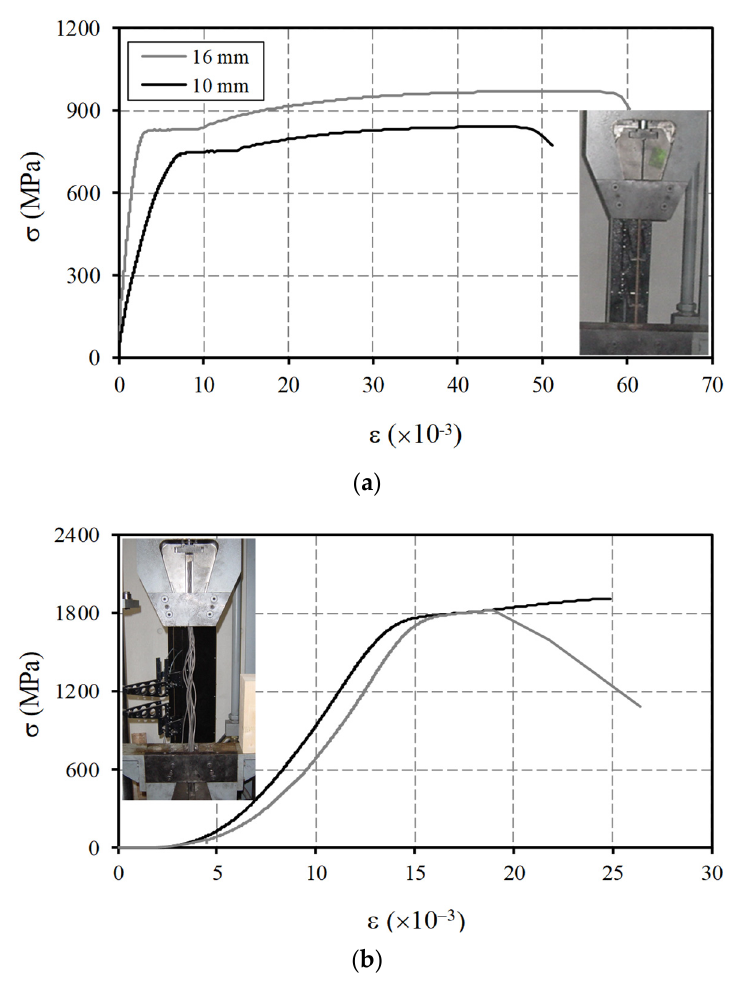
σ ε – curves for reinforcement: ( a ) ordinary and ( b ) prestress. Figure 4. Uniaxial σ – ε curves for reinforcement: ( a ) ordinary and ( b )